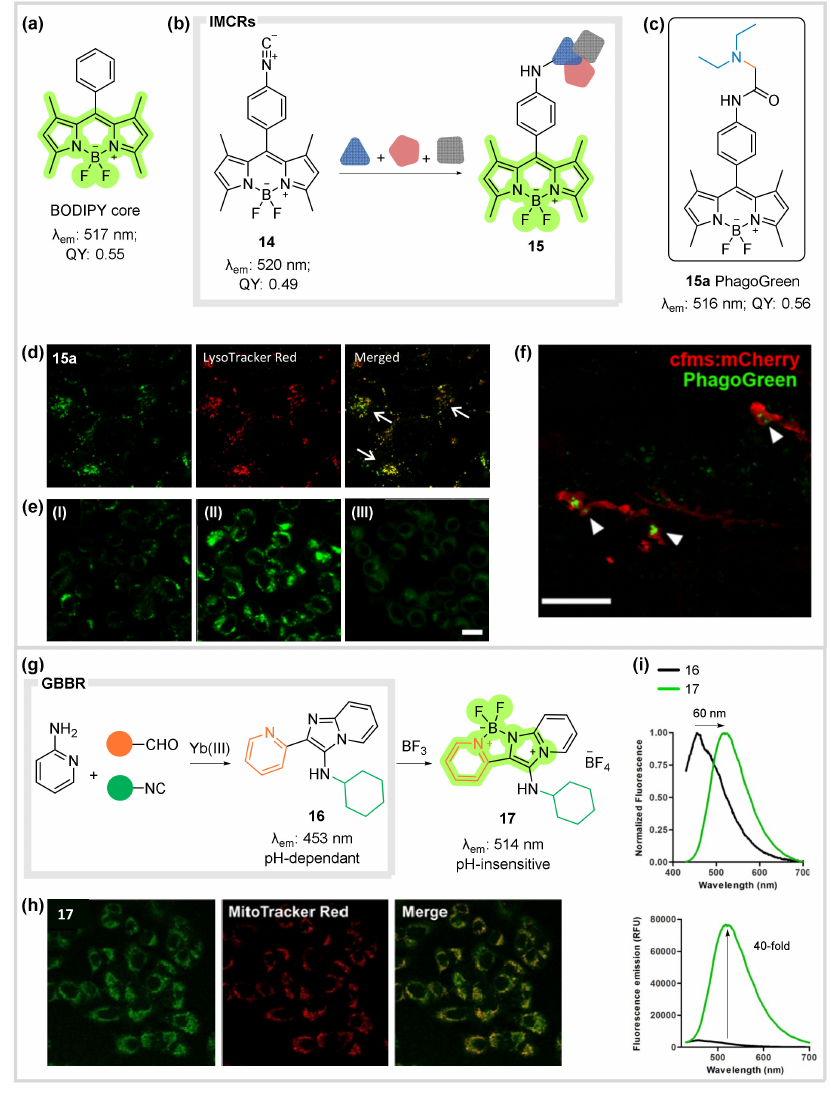
Figure 7. ( a ) Structure and photophysical properties of the BODIPY core. ( b ) Isocyanide deriva- tized BODIPY scaffold and generation of compounds 15 through various IMCRs. ( c ) Structure and photophysical properties of selected probe 15a , Phagogreen. ( d ) Co-incubation of 15a and Lyso- Tracker Red in A549 cells. ( e ) RAW 264.7 macrophages were treated with 15a . Fluorescence of 15a in ( I ) non-activated macrophages, ( II ) zymosan-activated macrophages, and ( III ) zymosan-activated macrophages treated with bafilomycin A. ( f ) Still from time-lapse imaging of transgenic zebrafish with m-Cherry-labelled macrophages treated with PhagoGreen. Scale bars: 20 µ m. Sections ( d – f ) from ref. [47] (O. V á zquez-Romero et al, J. Am. Chem. Soc . 2013 , 135 , 16018) reproduced with